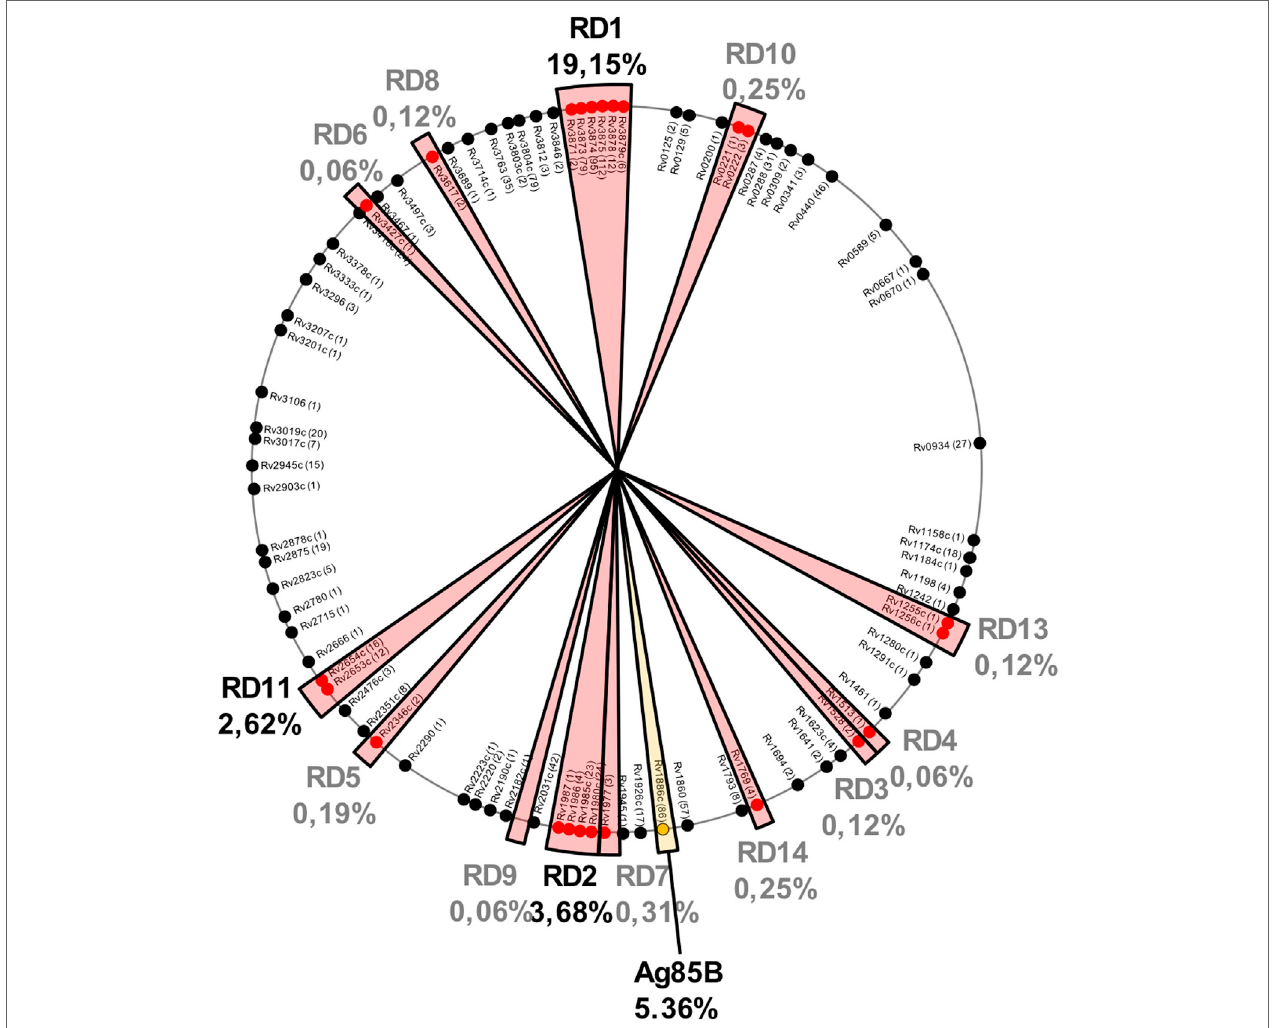
FiGURe 2 | Localization of 1,603 experimentally demonstrated T cell epitopes (according to http://IEDB.org) in the Mycobacterium tuberculosis H37Rv chromosome. Those regions absent in Bacille Calmette-Guérin (BCG) but present in M. tuberculosis are shown by red sectors and the percentage of epitopes contained in each region is indicated. Three of these regions (RD1, RD2, and RD11) contain > 25% of the total M. tuberculosis epitopes. It is also important to note that Ag85B (shown by a yellow sector) produced but not secreted by BCG also contains a high percentage of epitopes. Taken together, these results indicate that live attenuated vaccines based on the human pathogen, as MTBVAC, would present almost 40% more T cell epitopes than